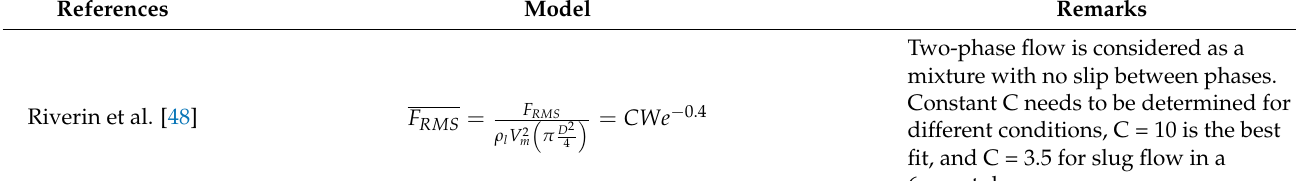
Table 2. Various correlation models developed to predict flow-induced